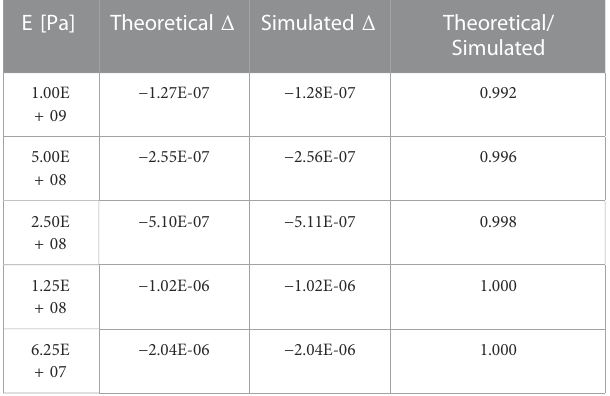
TABLE 3 Fixed Beam: Predicted [W L 4 /384EI] vs. Simulated Displacements, W = 490.5 [N/m], L = 10 [m], I = 100 [m 4 ]. E